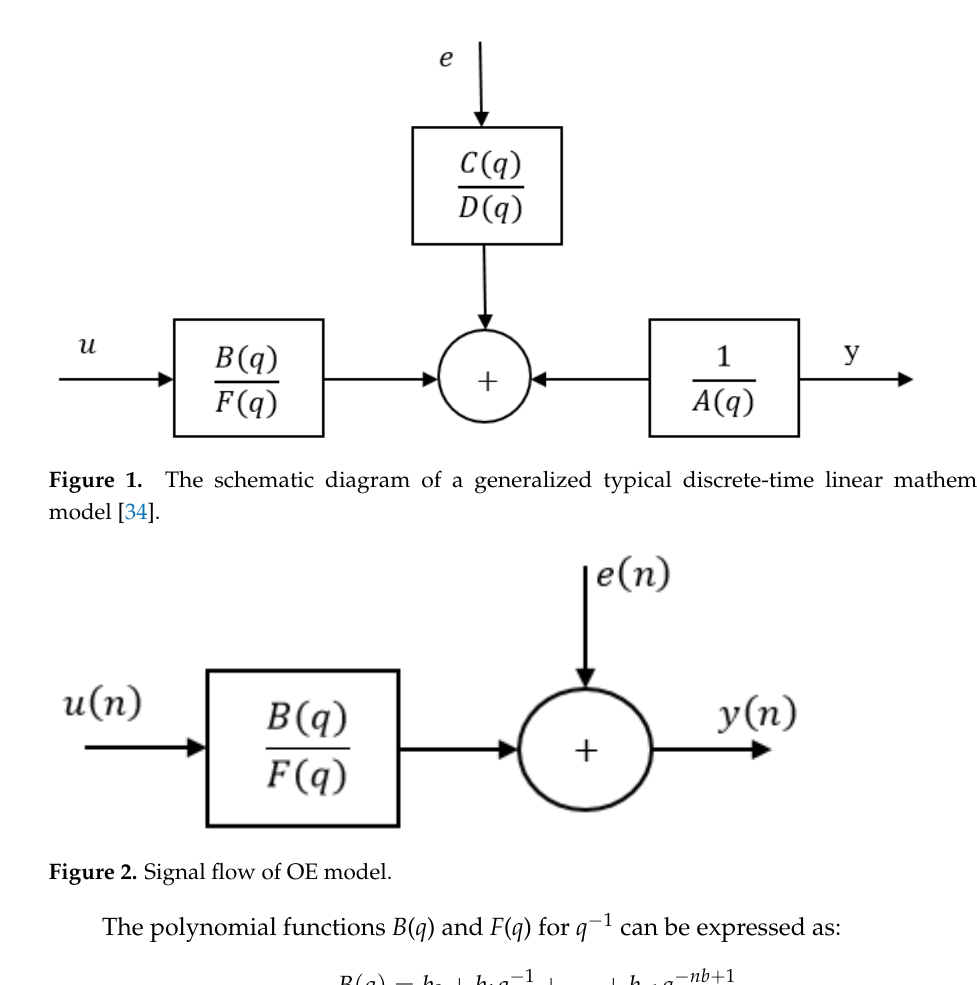
Figure 1. The schematic diagram of a generalized typical discrete-time linear mathematical model [34].